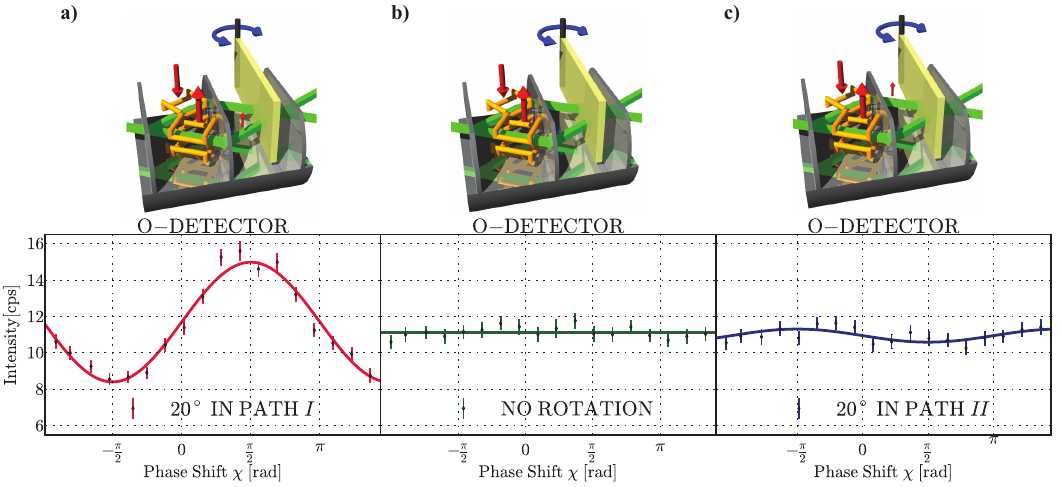
Figure 6. Measurement of (cid:104) ˆ σ z ˆ Π I (cid:105) w and (cid:104) ˆ σ z ˆ Π II (cid:105) w applying small additional magnetic fields. The intensity is plotted as a function of the relative phase χ . The solid lines represent least-square fits to the data and the error bars represent one s.d. ( a ) a magnetic field in path I; interference fringes appear; ( b ) a reference measurement without any additional magnetic fields, where due to the orthogonal spin states no interference fringes are observed; ( c ) a magnetic field in path II; interference pattens do not differ significantly from reference measurement, suggesting the neutrons’ spin component travels along path